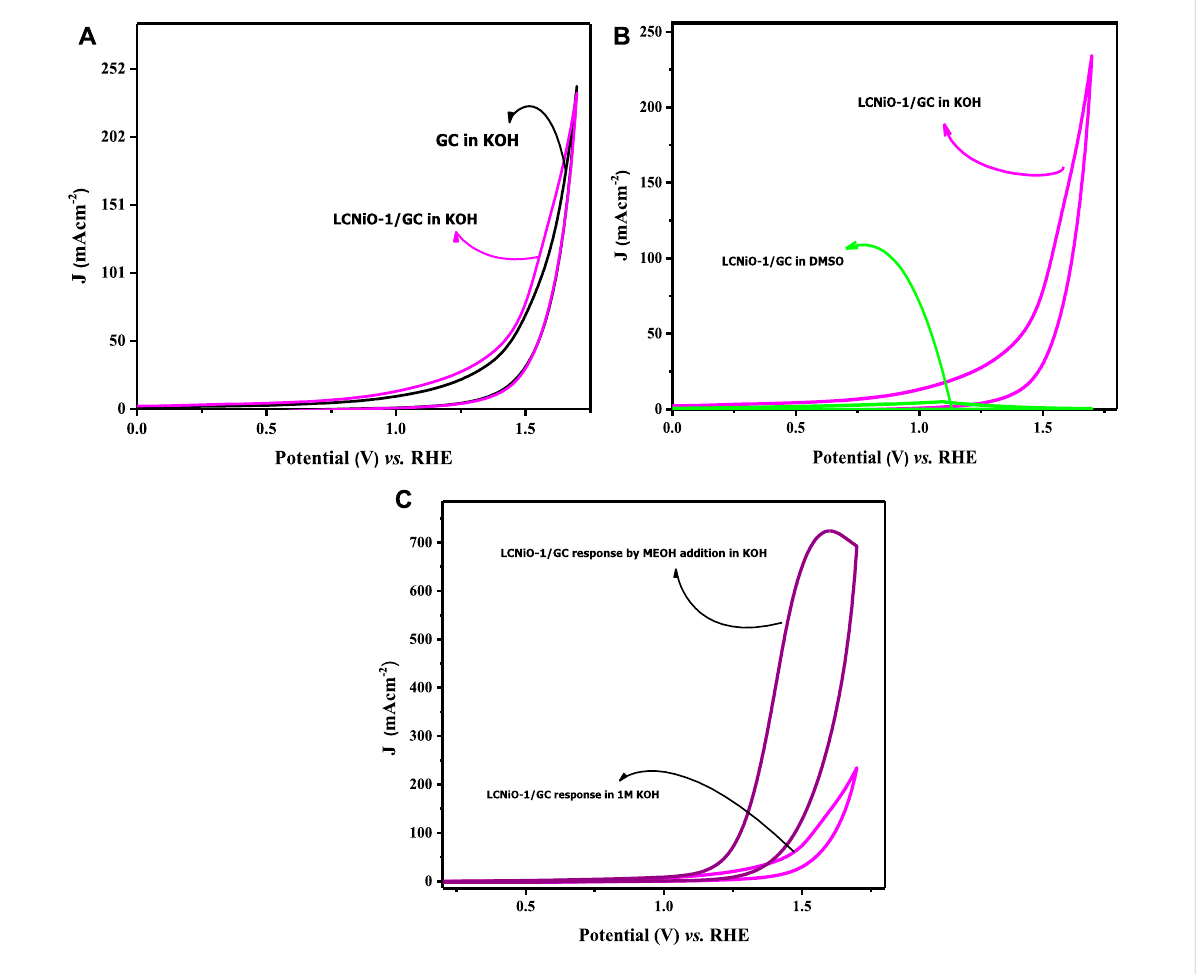
FIGURE 6 (A) Cyclic voltammetric response of OER for bare and LCNiO-1 modi fi ed GC electrode in KOH, (B) CV response in KOH (protic) and DMSO (aprotic) solvent at LCNiO-1 modi fi ed electrode, and (C) cyclic voltammogram for OER in KOH and methanol/KOH at LCNiO-1- modi fi ed